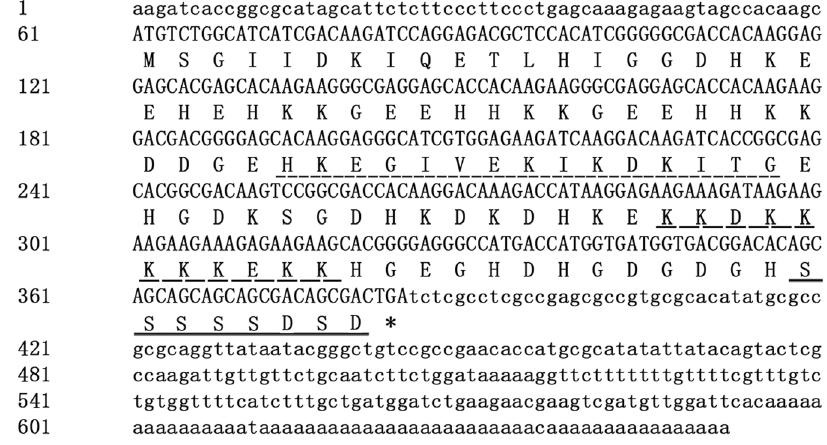
Figure 1. Sequence analysis of the ZmDHN13 protein. Nucleotide sequence of ZmDHN13 cDNA together with its predicted amino acid sequence. The putative different conserved segments are indicated as the K-segment (short-dashed line), the NLS segment (long-dashed line) and the S-segment (solid line).